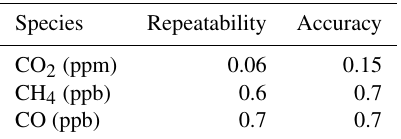
Table 2. FTIR analyser 5min repeatability and accuracy for CO 2 , CH 4 and